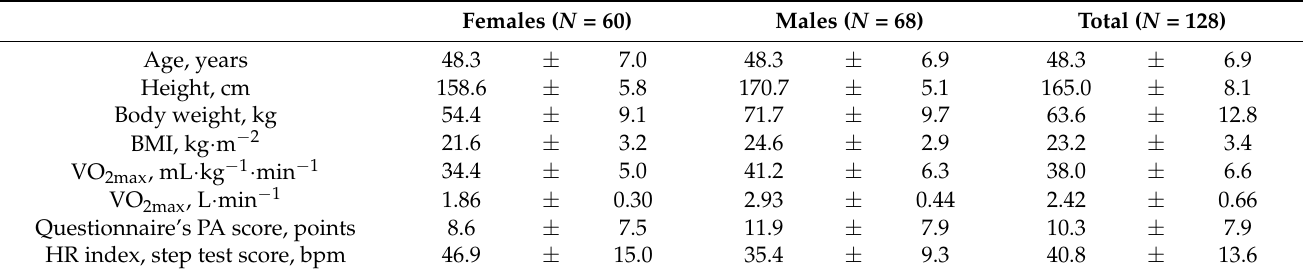
Table 1. Characteristics of the study